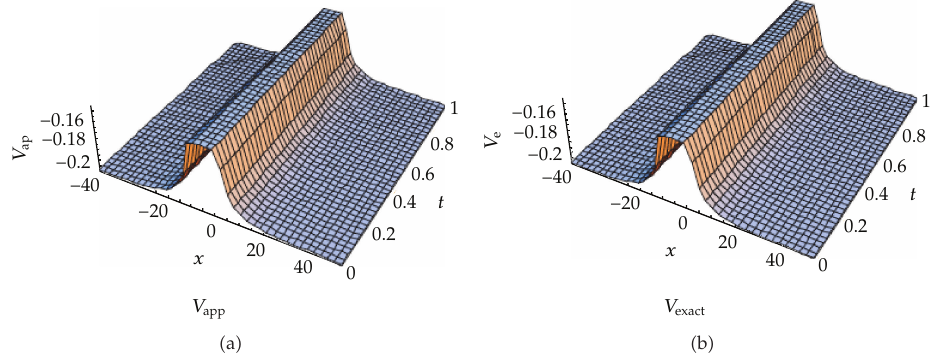
Figure 6: The approximate solution (cid:2) 5.28 (cid:3) in comparison with the exact solution (cid:2) 5.23 (cid:3) if k (cid:7) 0 . 1 ,c (cid:7) 0 . 2 ,ξ 0 (cid:7) 2 , and ξ 1 (cid:7)